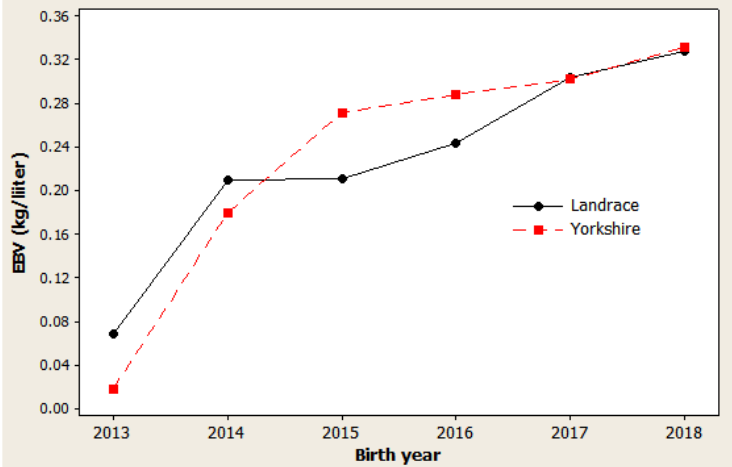
Figure 3. Genetic trend of litter weight at the 21st day in Danish Landrace and Yorkshire pigs by year of birth. Regression coefficients were 0.0461 kg/yr (p = 0.005) for Landrace and 0.0557 kg/yr (p = 0.016) for Yorkshire pigs.